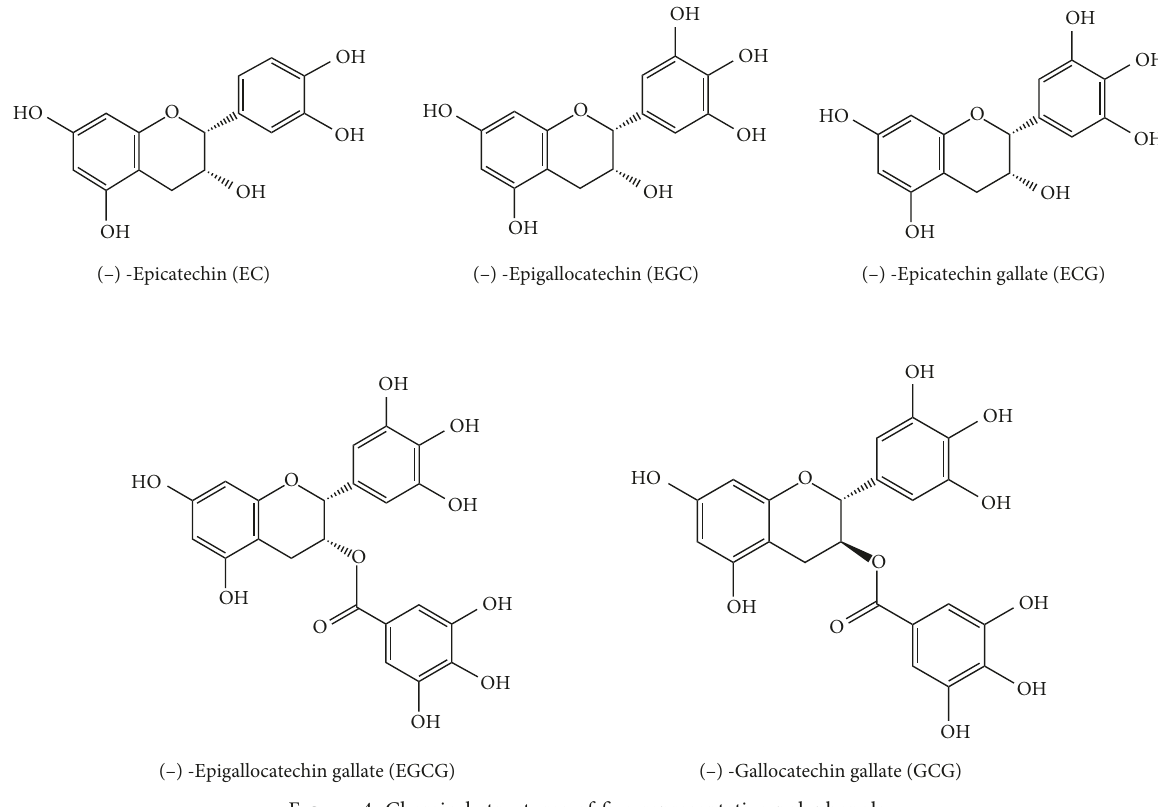
Figure 4: Chemical structures of five representative